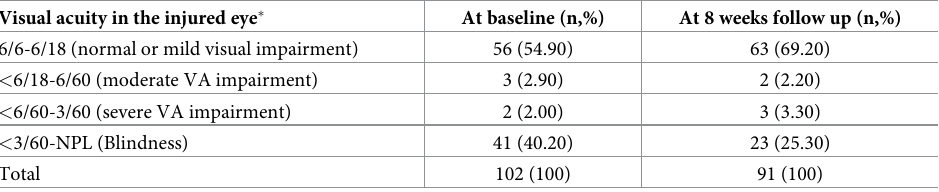
� Categorized according to the World Health Organization classification of visual